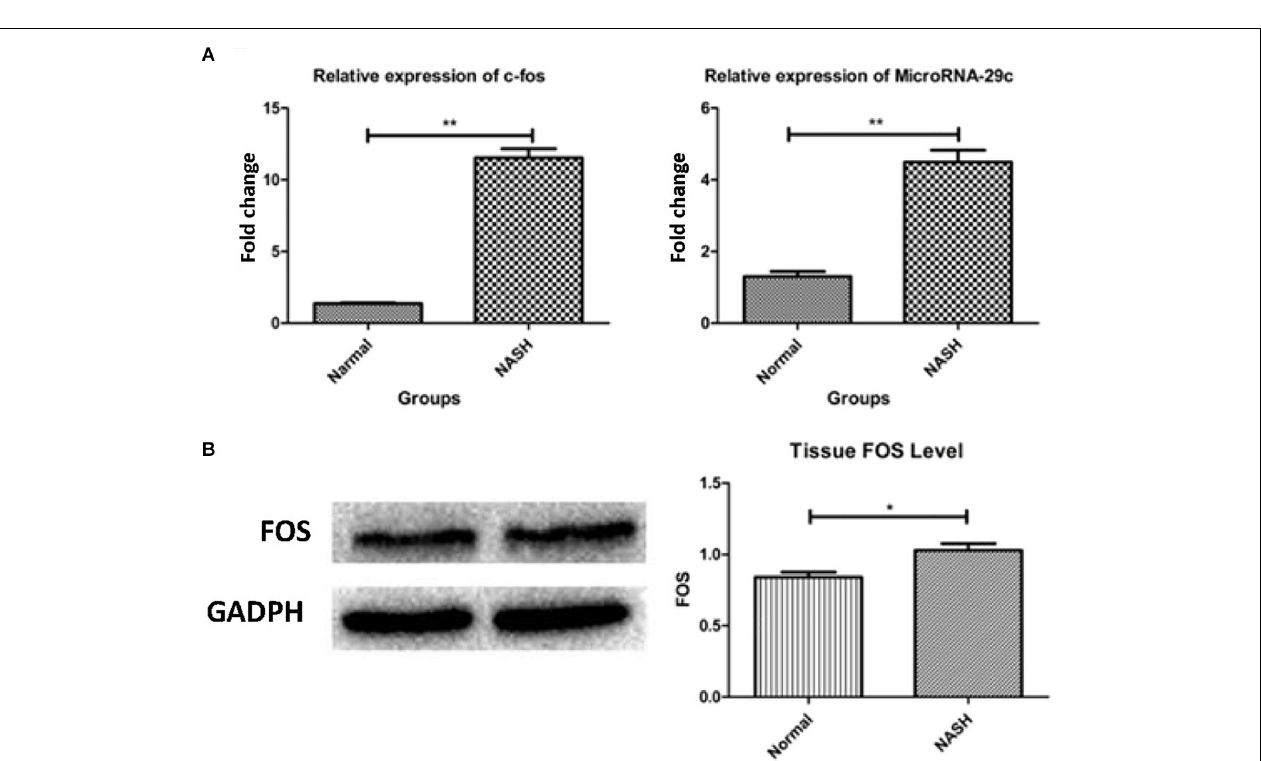
FIGURE 7 | The expression of FOS gene and microRNA-29c. (A) Represents relative expression of FOS and microRNA-29c by RT-PCR assay. (B) Shows tissue FOS level by WB. * p < 0.05, ** p < 0.01.